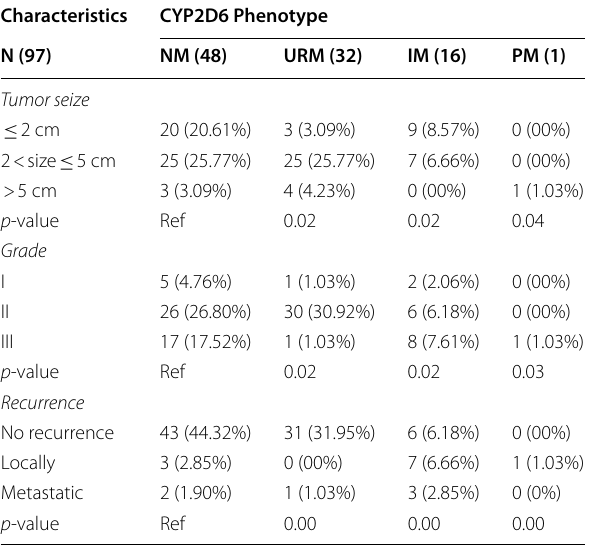
Table 3 Clinical characteristics of patients in association with CYP2D6